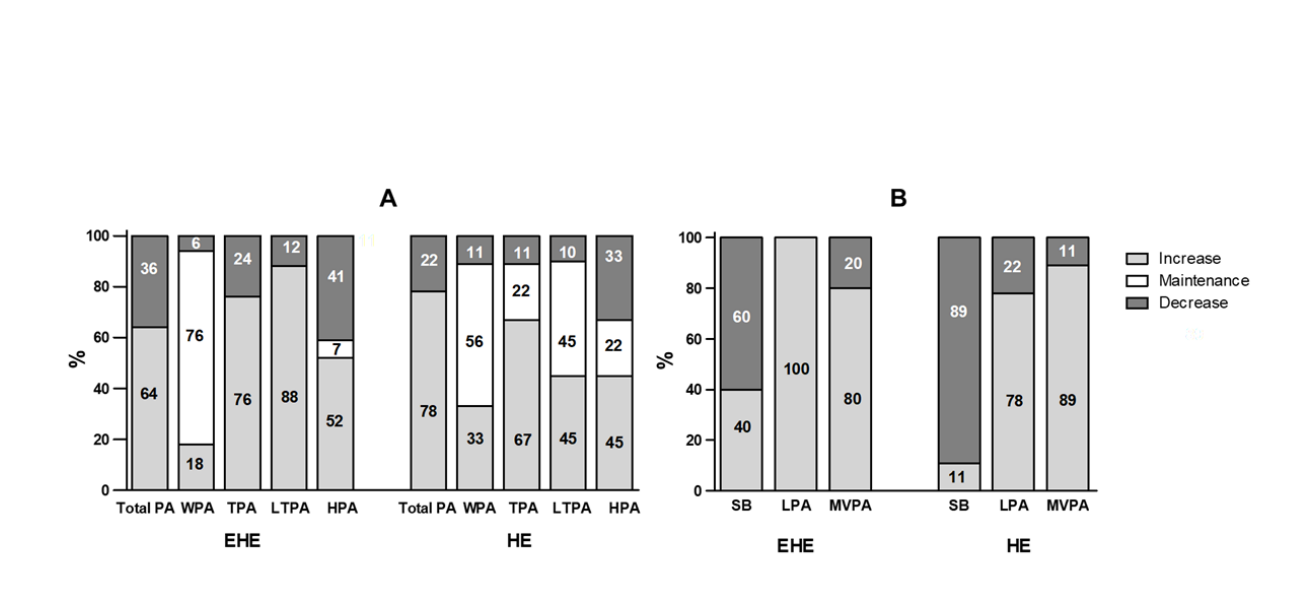
Fig. 2 - A: Delta frequency (Δ = post – pre-intervention) for the total PA and leisure, work, transport, and household-related PA domains of the participants of the EHE and HE group. 1B: Delta frequency for the intensity of PA and for the time in sedentary behavior for the participants of the EHE and HE groups.